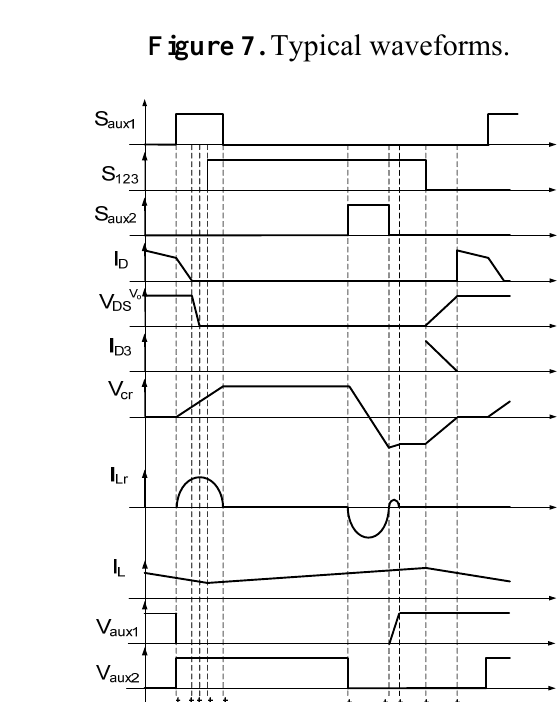
Figure 7. Typical